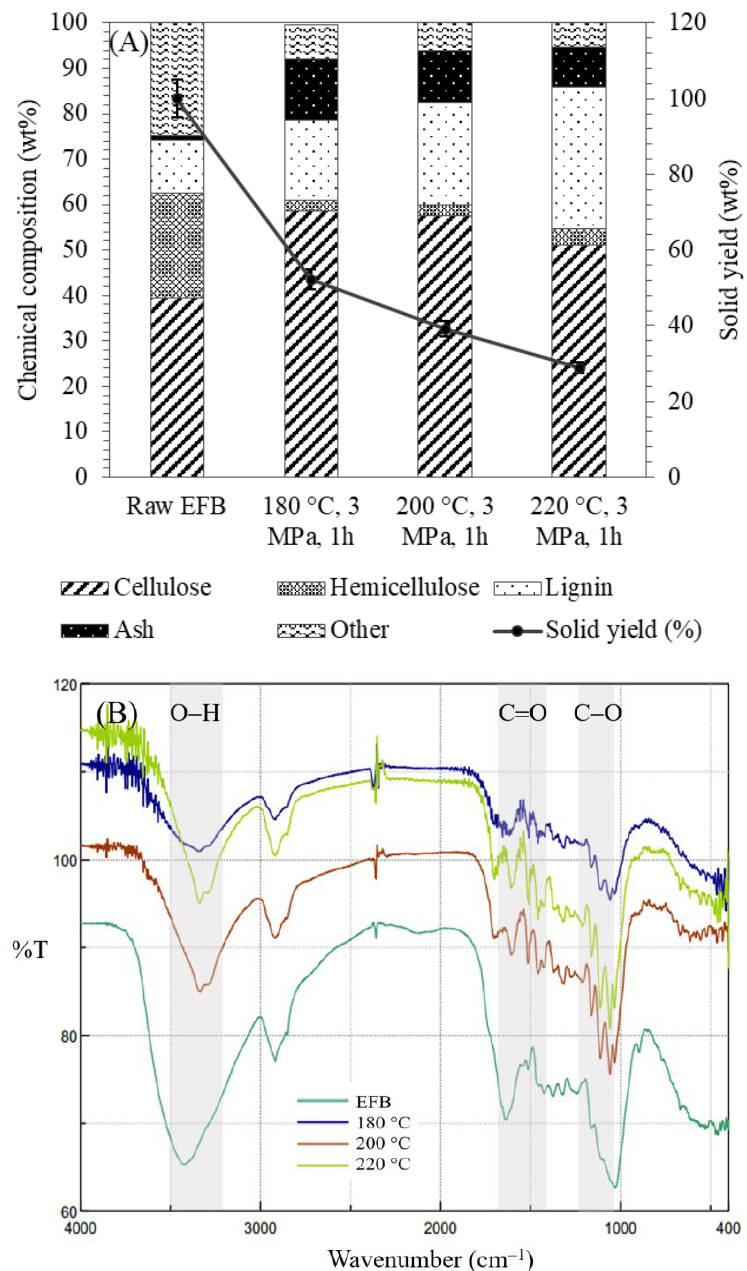
Figure 1. ( A ) Chemical composition, solid yield and ( B ) FTIR spectra of pretreated EFB at different hydrothermal temperatures at 180 °C, 200 °C and 220 °C for 1 h at 3 MPa. hydrothermal temperatures at 180 ◦ C, 200 ◦ C and 220 ◦ C for 1 h at 3